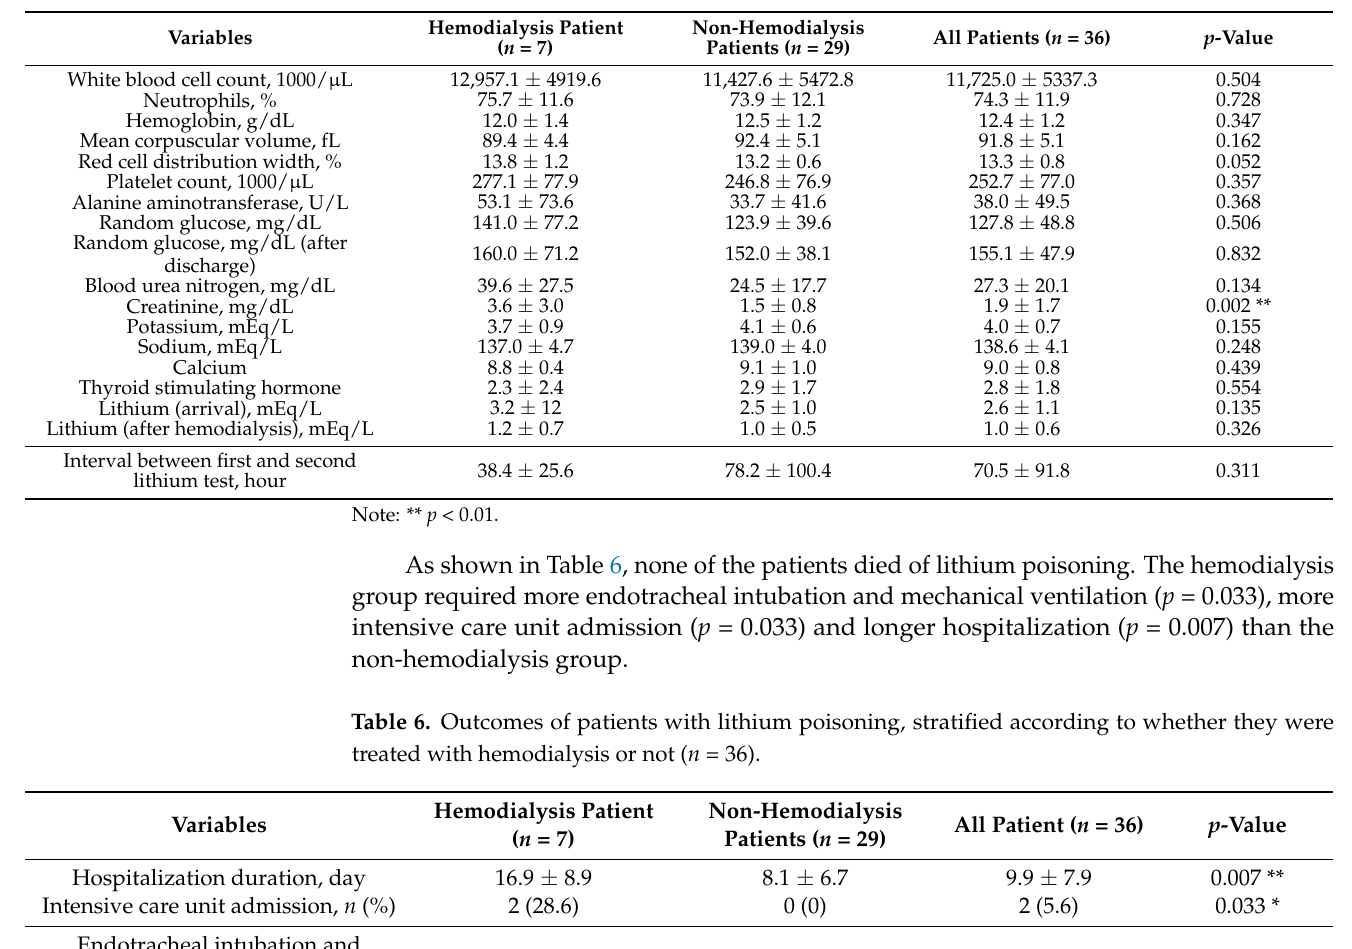
Table 5. Laboratory data of patients with lithium poisoning, stratified according to whether they were treated with hemodialysis or not ( n = 36).